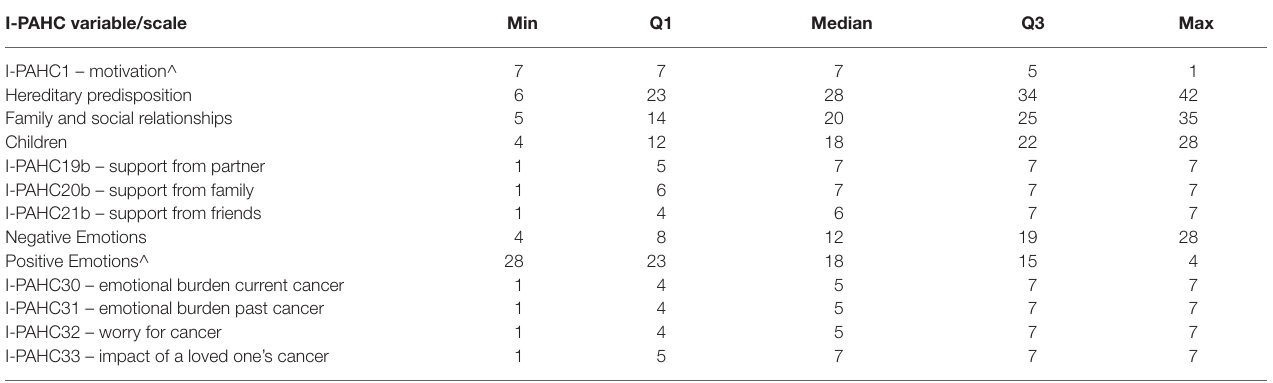
TABLE 3 Descriptive statistics of scores in the I-PACH items and scales. I-PAHC variable/scale Min